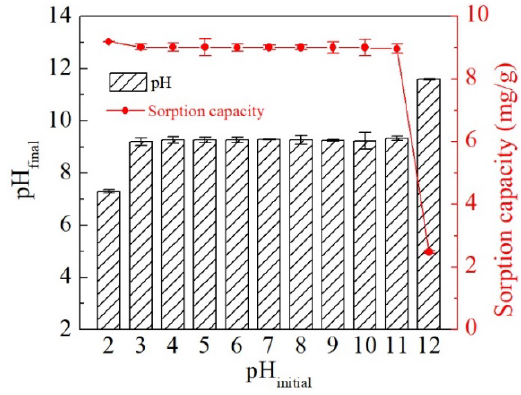
Figure 8. Effect of initial pH on tungstate sorption by delaminated iron-based LDH with reaction conditions: initial tungsten concentration = 0.1 mM, solid/solution ratio = 2 g/L, reaction time = 24 h, and T = 25 °C.